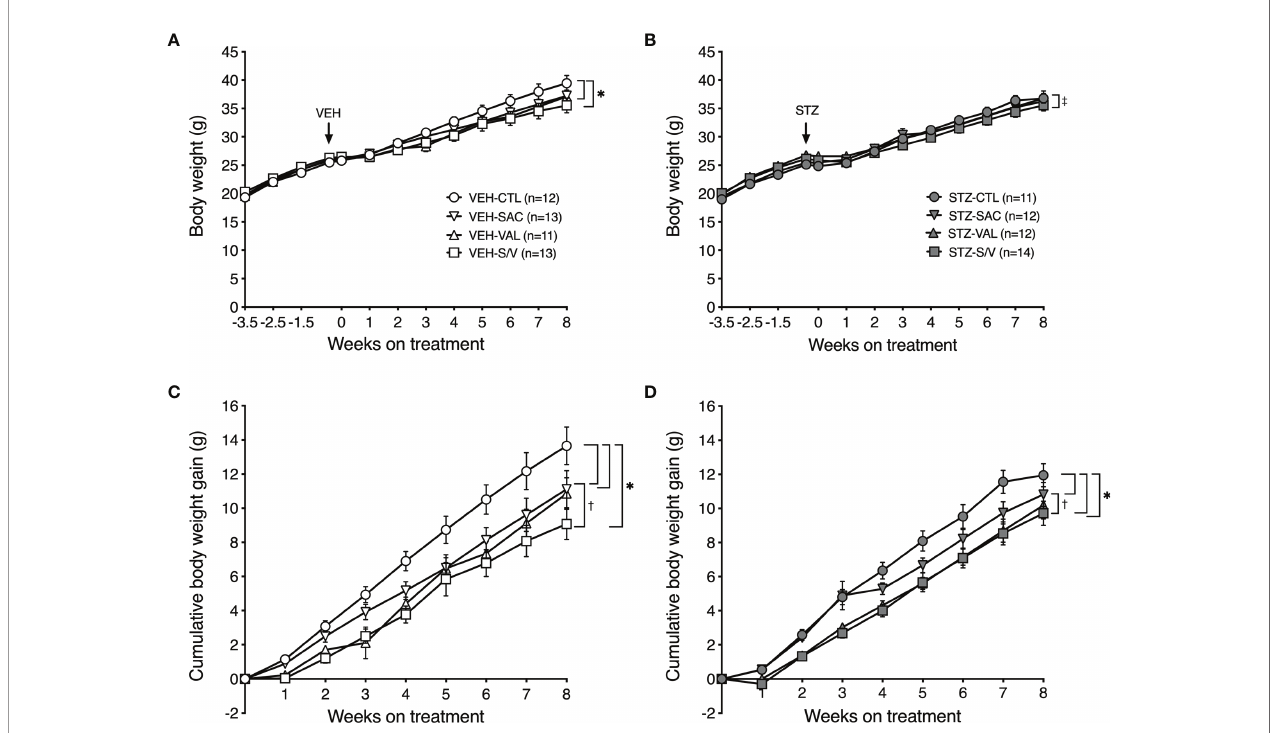
FIGURE 6 | Sacubitril, valsartan and sacubitril/valsartan reduce body weight gain in both obese and diabetic mice. Body weight over time in high fat-fed mice injected with vehicle ( A ; VEH) or streptozotocin ( B ; STZ), and then treated for 8 weeks with control (circles, CTL), sacubitril (inverted triangles, SAC), valsartan (triangles, VAL) or sacubitril/valsartan (squares, S/V). The arrow shows when VEH or STZ was injected. Cumulative body weight gain over the 8-week treatment period in high fat-fed mice injected with VEH (C) or STZ (D) and treated with CTL, SAC, VAL or S/V. n=11-14/group. *p<0.05 SAC, VAL and S/V vs. CTL, ‡ p<0.05 VAL vs. S/V, † p<0.05 SAC vs.